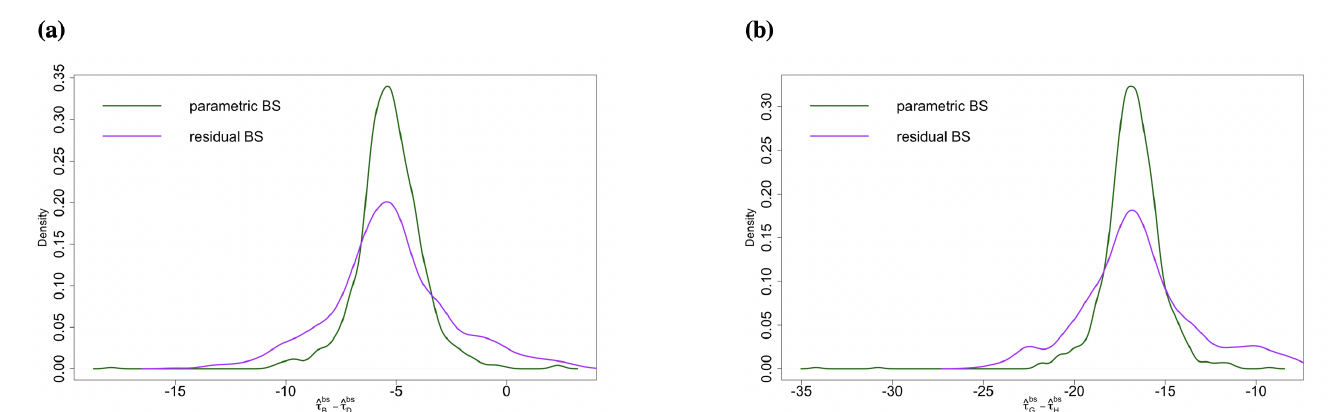
Figure 6. Comparison: empiricalparametric bootstrap sampling distribution and empirical residual bootstrap sampling distribution of ( a ) ˆ τ bs but not in the residual bootstrap case. ( b ) ˆ τ bs